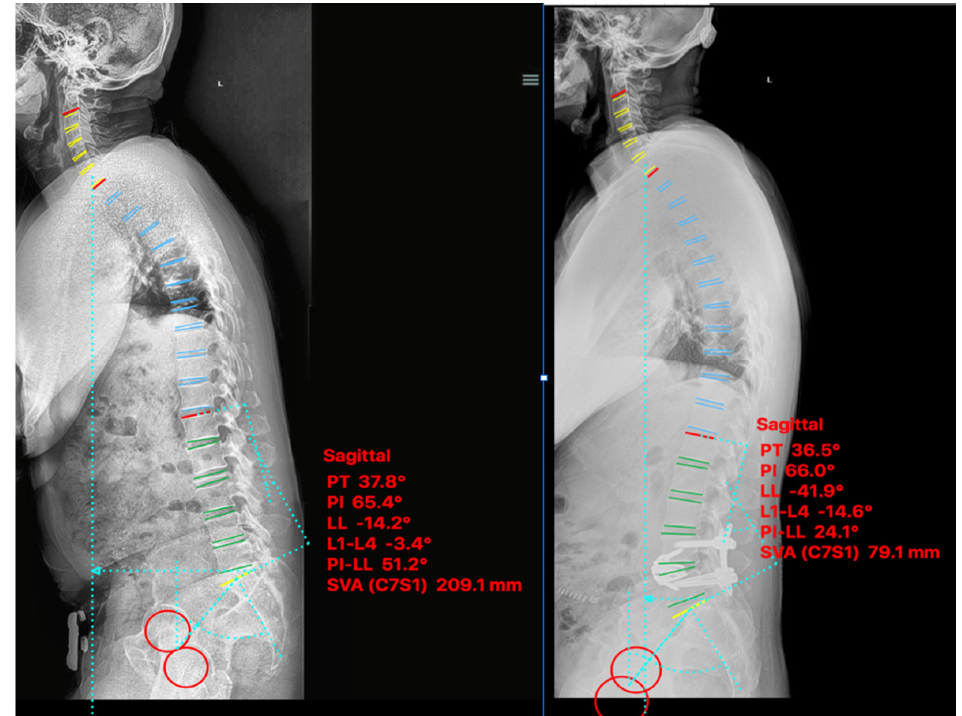
Figure 5. Case III. Pre-psoas interbody fusion for L4-5 spondylolisthesis with anterior column re- lease and with an expandable 30° cage. Lateral standing scoliosis radiographs. Pre-operative imag- and an expandable 30 ◦ cage. Lateral standing scoliosis radiographs. Pre-operative imaging ( left ), ing ( left ), 1-month post-operative imaging ( right ). 1-month post-operative imaging ( right